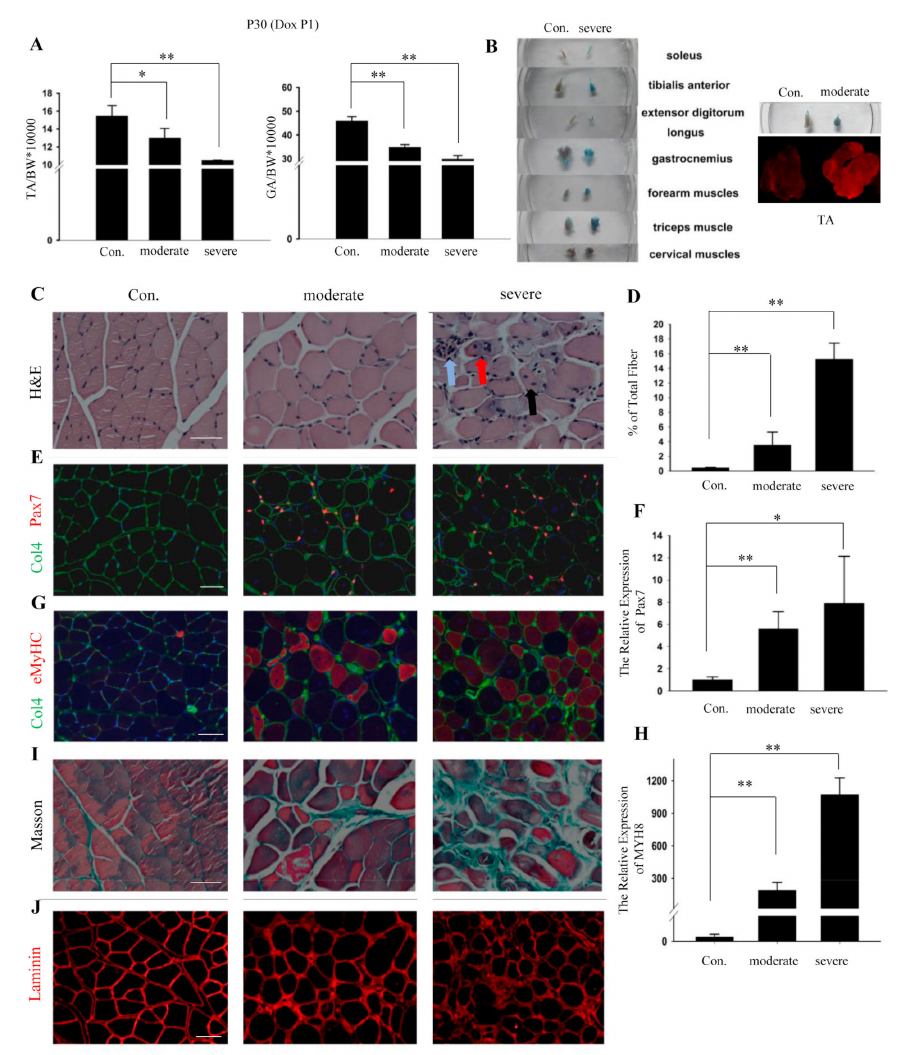
Figure 3. High miR-29 expression in juvenile mice induces skeletal muscle injury. ( A ) Quantification of tibialis anterior (TA) and gastrocnemius (GA) muscles weight at 30 days (n = 5). *, p < 0.05; **, p < 0.01. ( B ) Detection of myofibers damage in individual whole-body muscle following i.p. injection of 1% EBD 24 h prior to sampling. Comparison of tibialis anterior muscles between control and moderate dTG mice. And immunofluorescence analyses of EBD in the tibialis anterior muscles squash slide between the control and moderate mice. ( C ) H&E staining of tibialis anterior muscles. ( D ) Quantification of the rate for central nuclear myofibers. **, p < 0.01. ( E ) Immunofluorescence analyses of Pax7 (red) and collagen IV (green) in tibialis anterior muscles of control and dTG mice. Scale bars: 50 µ m. ( F ) Expression analysis of Pax7. GAPDH was used as an internal normalized reference. The values represent the mean ± SEM (n = 3). *, p < 0.05; **, p < 0.01. ( G ) Immunofluorescence analyses of eMyHC (red) and collagen IV (green) in tibialis anterior muscles of control and dTG mice. Scale bars: 50 µ m. ( H ) Expression analysis of MYH8. ( I ) Masson staining of the tibialis anterior muscles. Scale bars: 50 µ m. ( J ) Immunofluorescence analyses of Laminin in tibialis anterior muscles of control and dTG mice. Scale bars: 50 µ m. Con.: control mice, moderate: moderately damaged dTG, severe: severely damaged